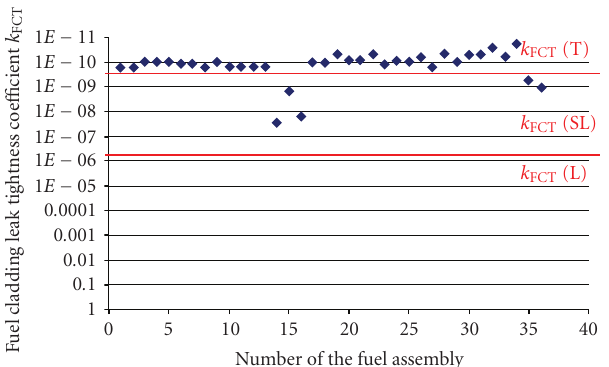
Figure 3: Limit values for the fuel cladding leak tightness coe ffi cient k FCT .